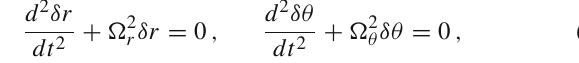
on the left of each curve). It should be mentioned that the curves are symmetric with respect to the changes ((cid:2), y c ) → ( − (cid:2), − y c ) . (Right): The3-dimensionalplotoftheaccretiondiskintheCartesiancoordinates ( X , Y , Z ) = ( r sin θ cos ϕ, r sin θ sin ϕ, r cos θ) . We choose (cid:2) = − 2 and a / M = 0 . 9. The disk is composed of the collection of all circular orbits. Notice that the coordinate along the Z -axis is amplified. The length in these figures is rescaled with respect to